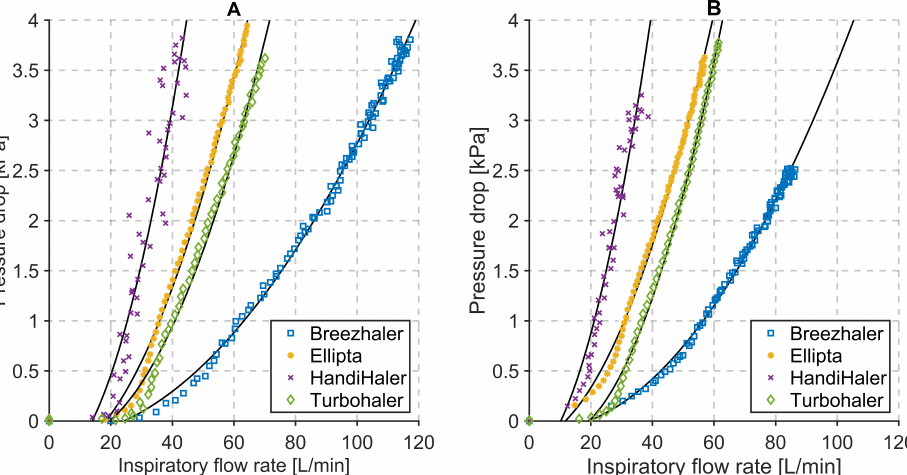
Figure 4. Relationships between inspiratory flow rate and pressure drop of four commercial DPIs during ( A ) characterization measurements and ( B ) respiration